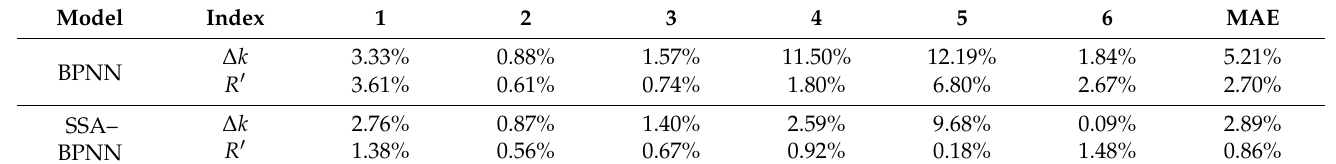
Table 9. Comparison of relative errors between BPNN and SSA–BPNN.